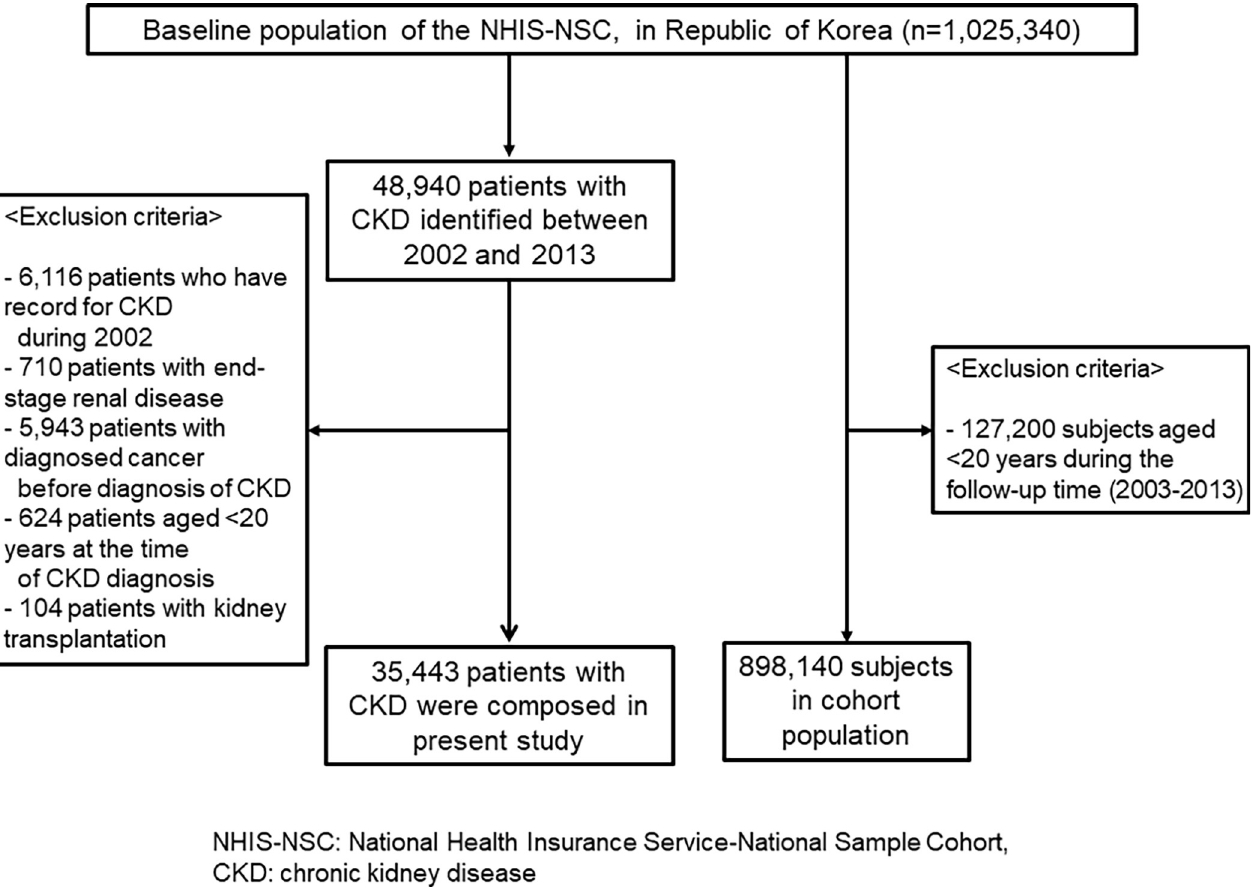
Fig 3. Study flowchart. Abbreviations: NHIS-NSC: National Health Insurance Service-National Sample Cohort; CKD, chronic kidney disease.